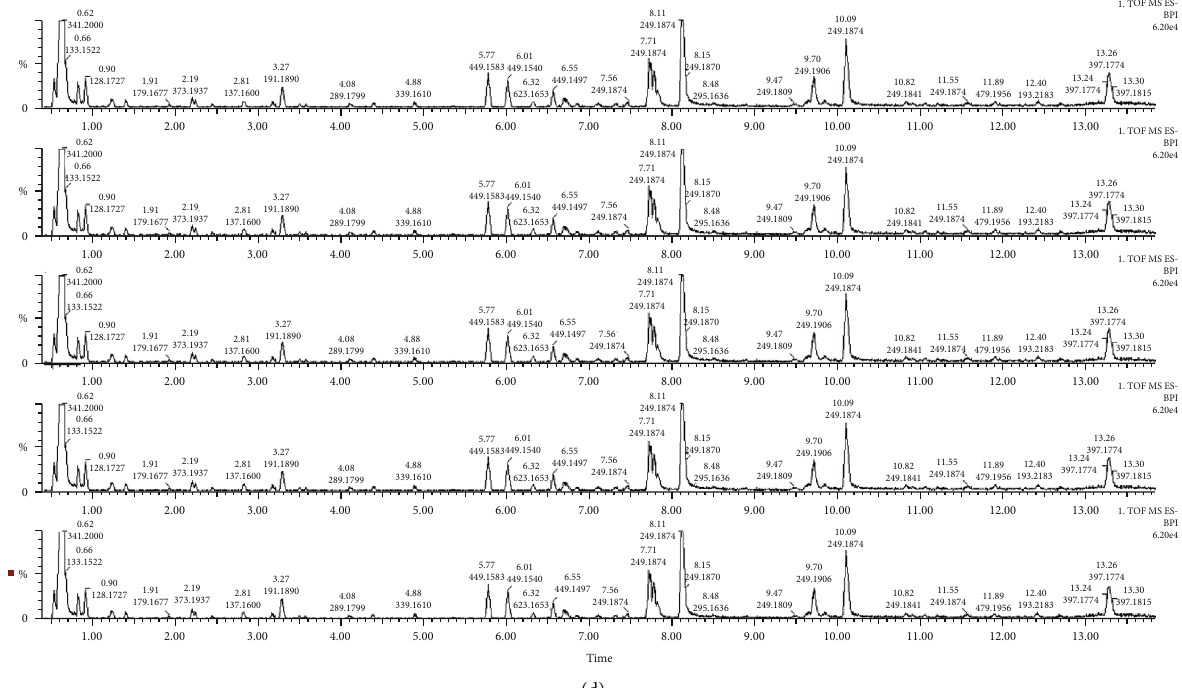
Figure 1: Total ion chromatograms of YXJD. Five groups of YXJD consisting of di ff erent batches were diluted to 0.06g/mL and precipitated with an equal amount of methanol. The supernatants were obtained by centrifugation (10000rpm) for 40min and analyzed by UPLC-MS/MS using a mobile phase consisting of acetonitrile and 0.1% formic acid aqueous solution with a gradient program. The external standard one- point method was used to calculate the sample content based on the following formula: control sample injection quantity/sample peak area = sample injection quantity/sample peak area (a, b). Total ion fl ow in ESI positive mode. Counts (%) versus acquisition time (min) (c). Total ion fl ow in ESI anion mode. Counts (%) versus acquisition time (min)